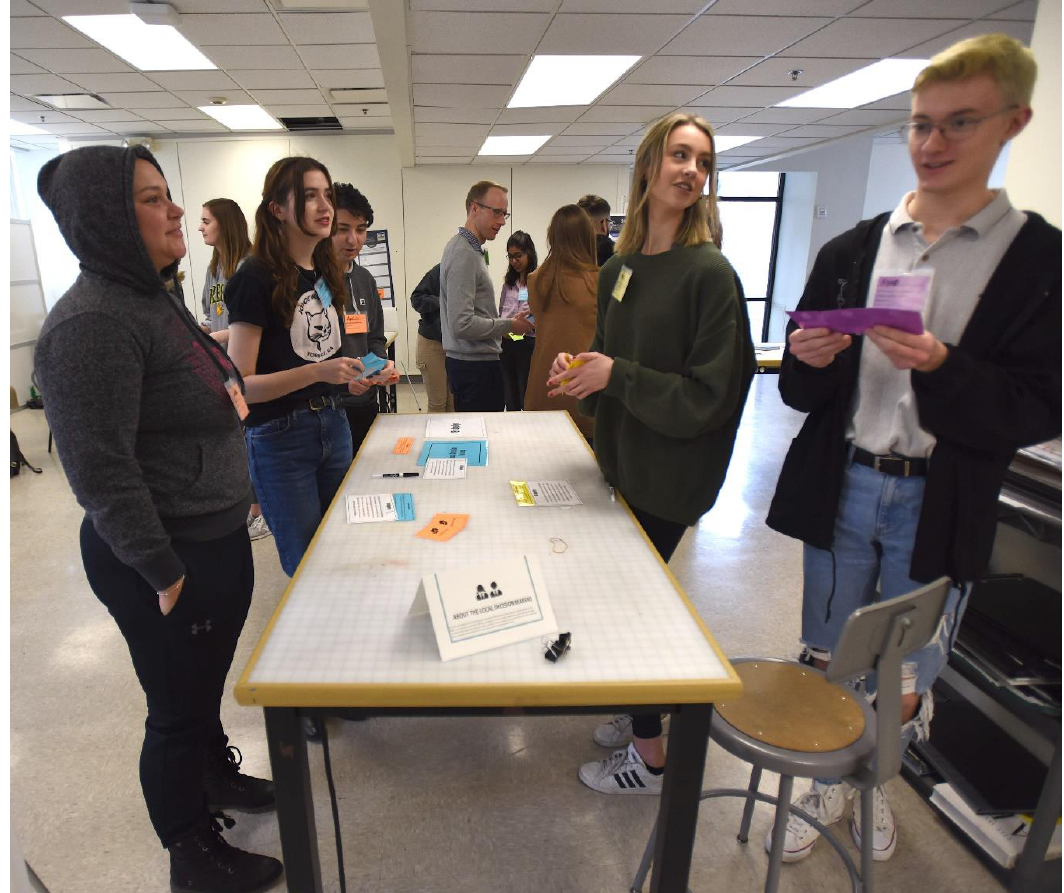
Figure 3. University of Nebraska-Lincoln (UNL) students are trading resources during the Response phase of the Ready for Drought? game. Photo by: Robert Matteson, National Drought Mitigation Center.